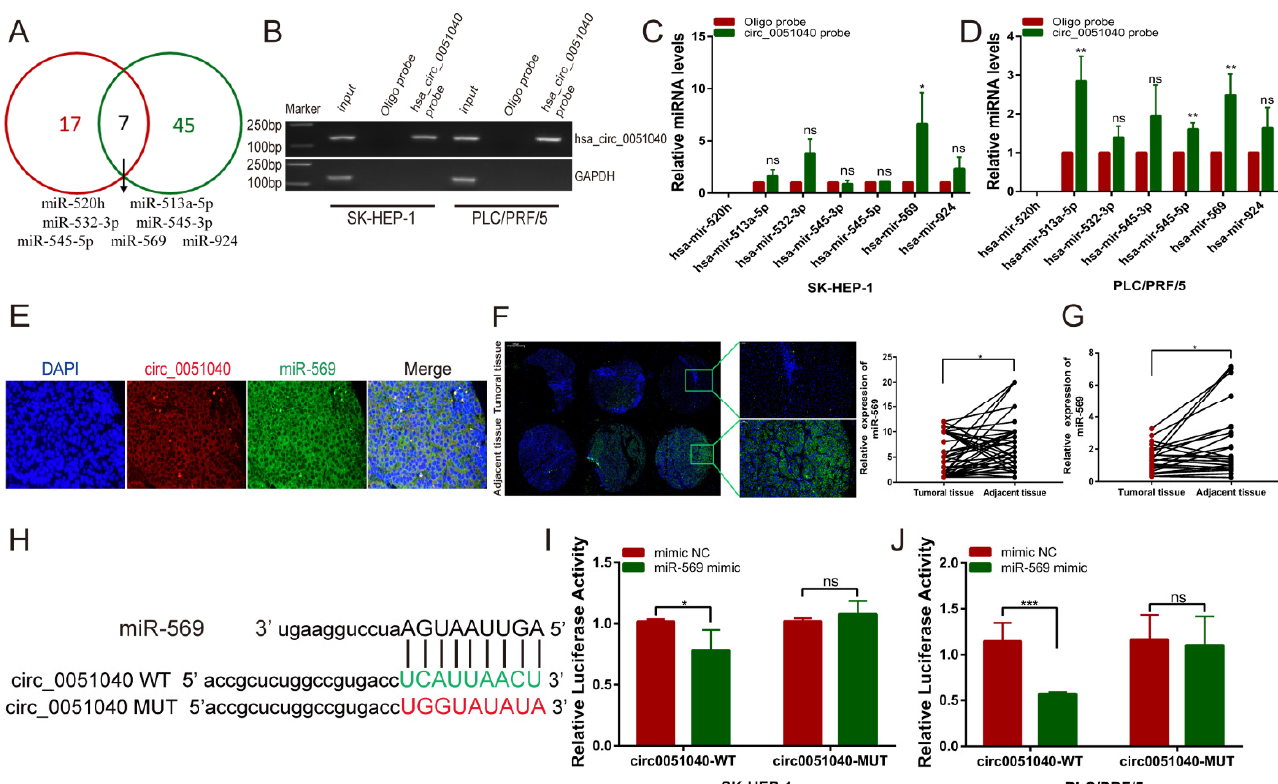
Figure 4. ( A ) Venn diagram analysis of the two databases’ (CirInteractome and circBank) identified seven miRNA candidates: miR-520h, miR-513a-5p, miR-532-3p, miR-545-3p, miR-545-5p, miR-569 and miR-924. ( B ) qRT-PCR and agarose gel electrophoresis results showed that hsa_circ_0051040 could be specifically pulled down by the hsa_circ_0051040 probe. ( C , D ) qRT-PCR analysis of the expression of 7 candidate miRNAs in the SK-HEP-1 and PLC/PRF/5 cell lysates after pulldown assay. Relative levels of hsa_circ_0051040 were normalized to input. ( E ) Co-localization of hsa_circ_0051040 (red color) and miR-569 (green color). The nuclei were stained with DAPI for blue color. ( F ) FISH for miR-569 in 49 pairs of HCC and adjacent tissue microarray. The cytoplasmic miR-569 was stained for green color, and the nuclei were stained with DAPI for blue color. ( G ) qRT-PCR analysis of miR-569 in paired HCC tissues compared with adjacent normal tissues. ( H ) Sequence alignment of binding sites between hsa_circ_0051040 and miR-569. ( I , J ) The relative luciferase activity of circ0051040-WT or circ0051040-MUT in the miR-569 mimic or NC group in SK-HEP-1 and PLC/PRF/5 cells. Statistical significance was assessed by two-tailed Student’s t test. The error bar indicates the SD. * p < 0.05; ** p < 0.01; *** p < 0.001; ns, not significant.